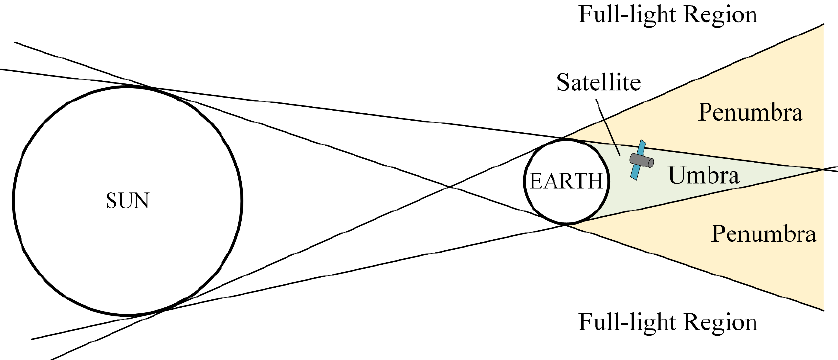
Figure 14. Umbra and penumbra area of an Earth eclipse.